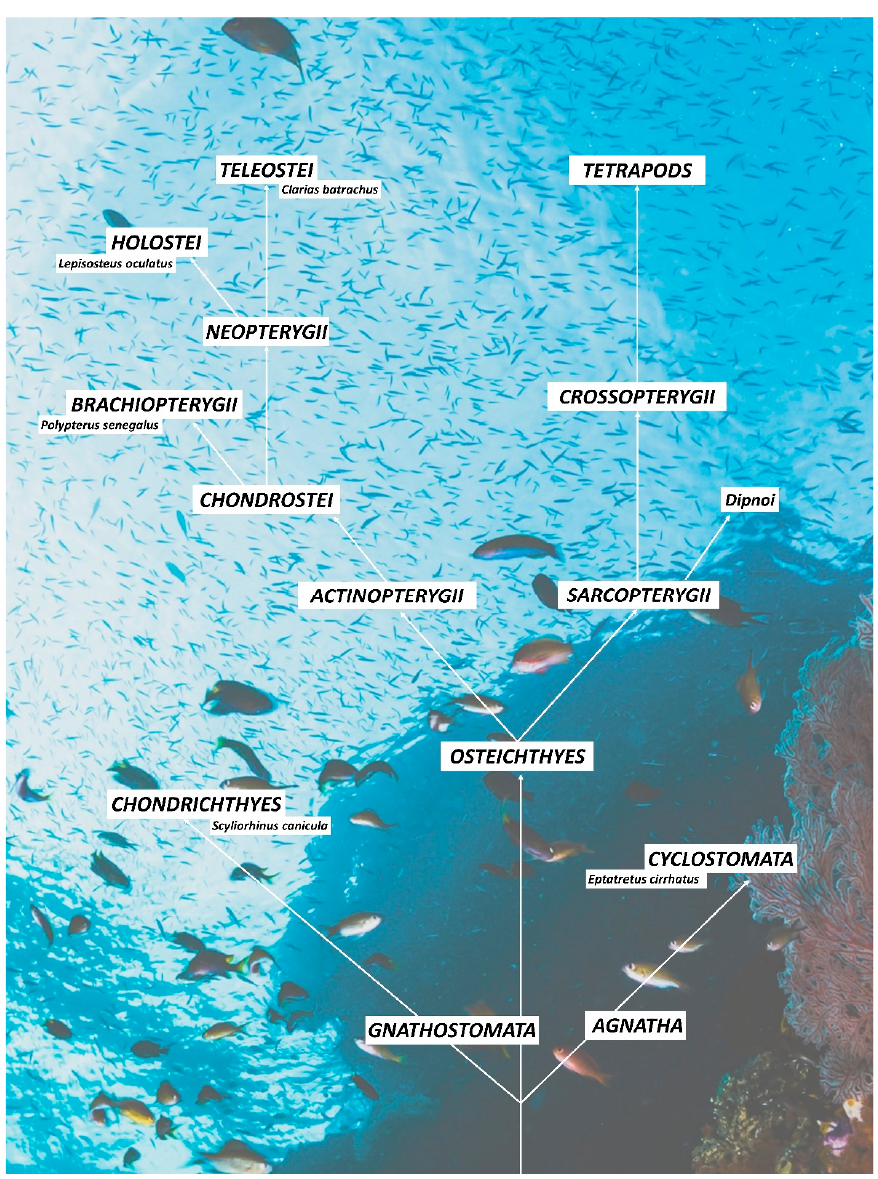
Figure 1. Evolutive relationships among the studied species. Agnatha and Gnathostoma evolved from a common ancestor. Cyclostomes (as the present myxines such as Eptatretus cirrhatus Forster, 1801) originated from the Agnatha, while Chondrichthyes (e.g., Scyliorhinus canicula Linnaeus, 1758) evolved from the Gnathostomata. The bony fishes also evolved from the Gnathostomata and have given two evolutionary lines: Sarcopterygii and Actinopterygii. The present tetrapods derived from the Sarcopterygii. Chondrostei developed from Actinopterygii. They gave rise to Brachiopterygii and Neopterygii. The former includes the Polypterus senegalus Cuvier, 1829. From the latter, the evolved Holostei (e.g., Lepisosteus oculatus Winchell, 1864) and Teleostei (e.g., Clarias batrachus Linnaeus,